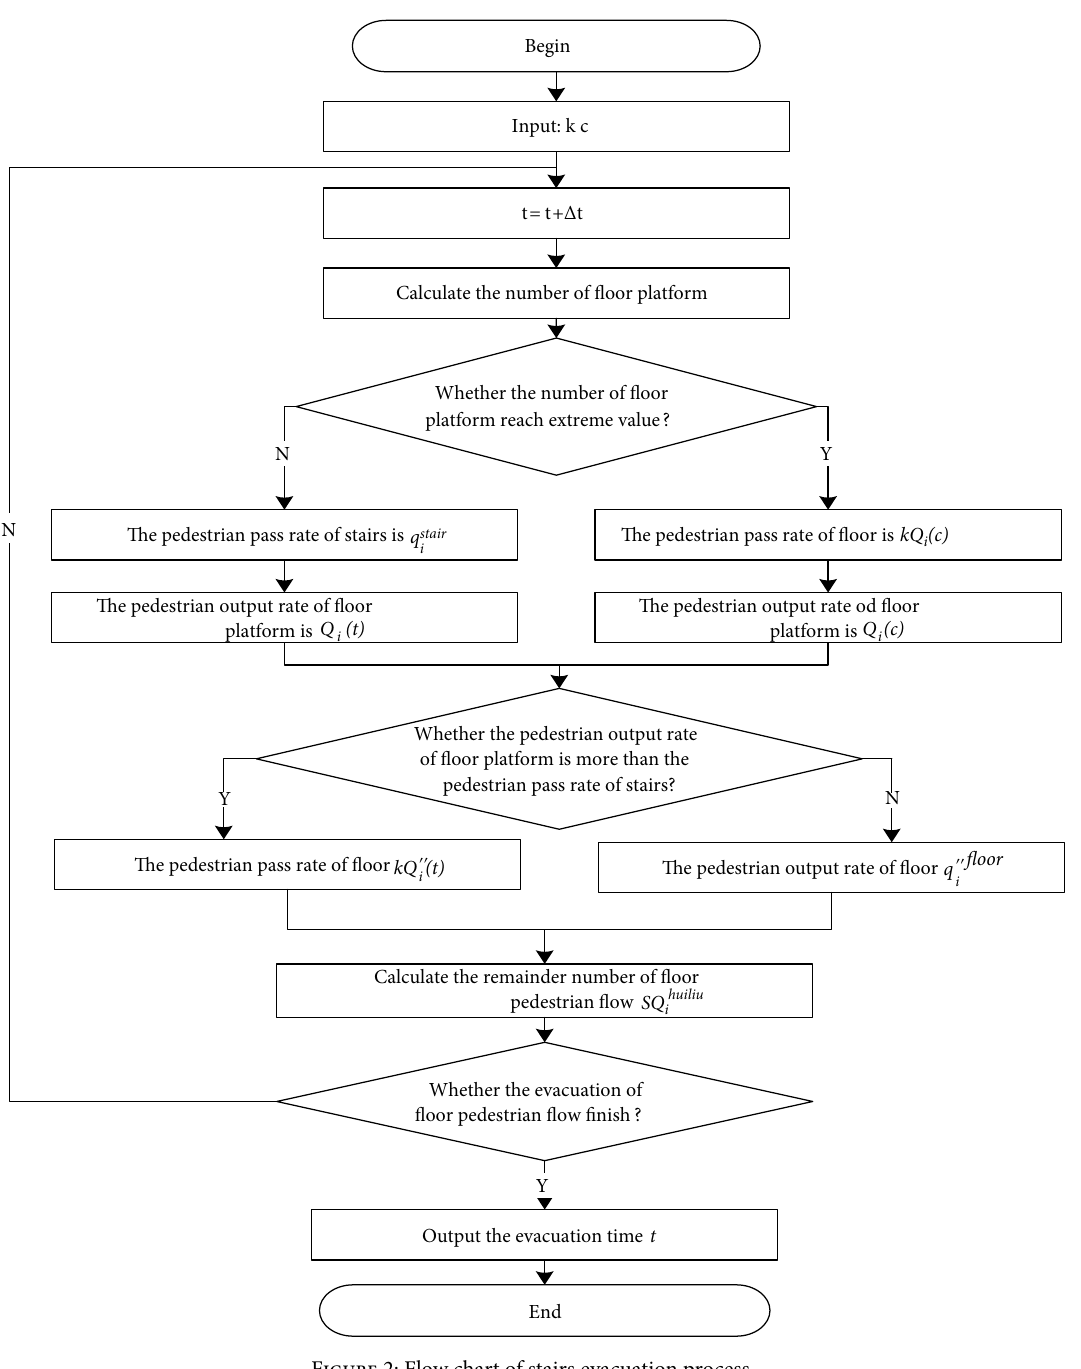
Figure 2: Flow chart of stairs evacuation